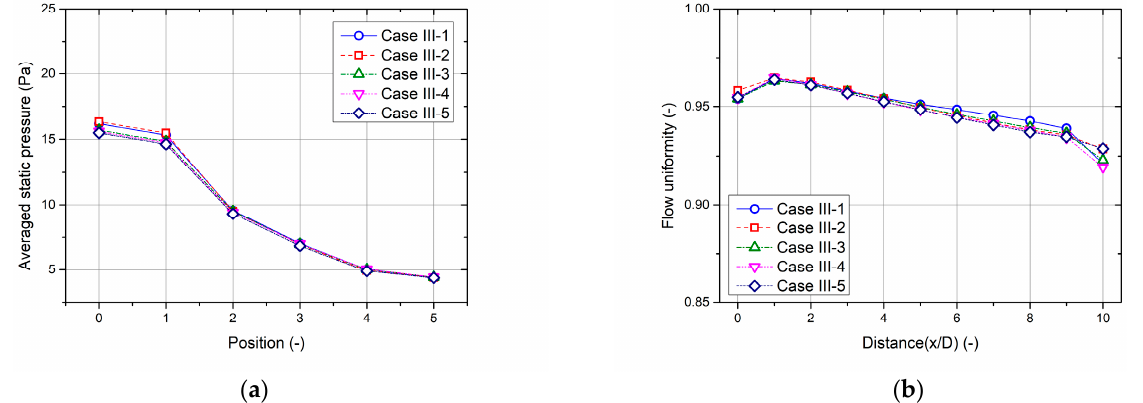
Figure 11. Simulation results: ( a ) the static pressure distribution; ( b ) flow uniformity distribution.